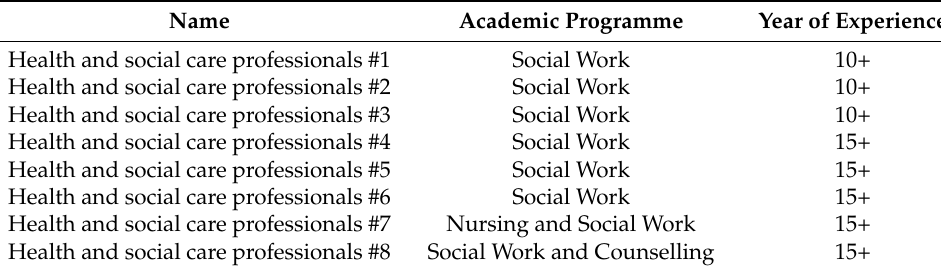
Table A1. Background of the health and social care